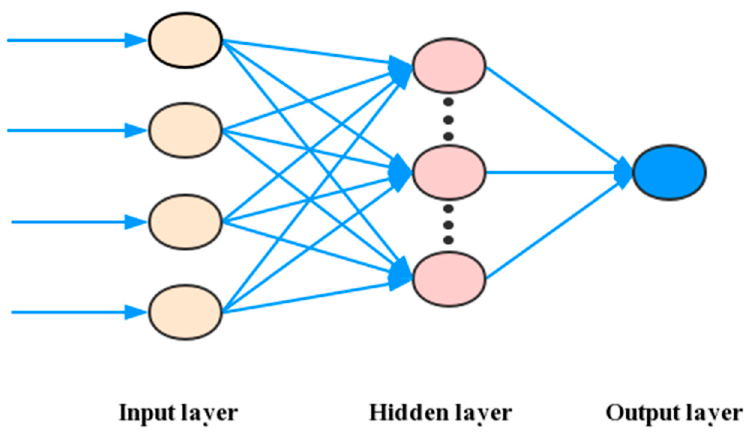
Figure 3. Schematic of the initial neural network model.